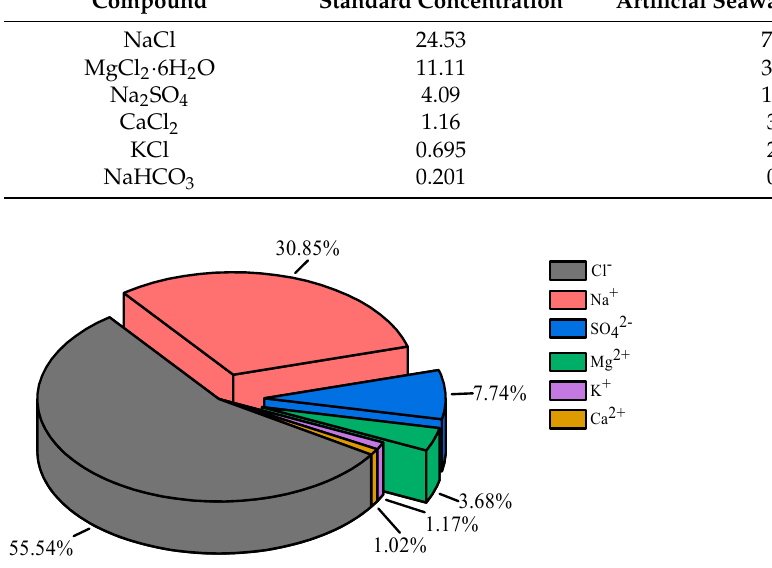
Figure 1. Mass percentage of main dissolved ions in artificial seawater.